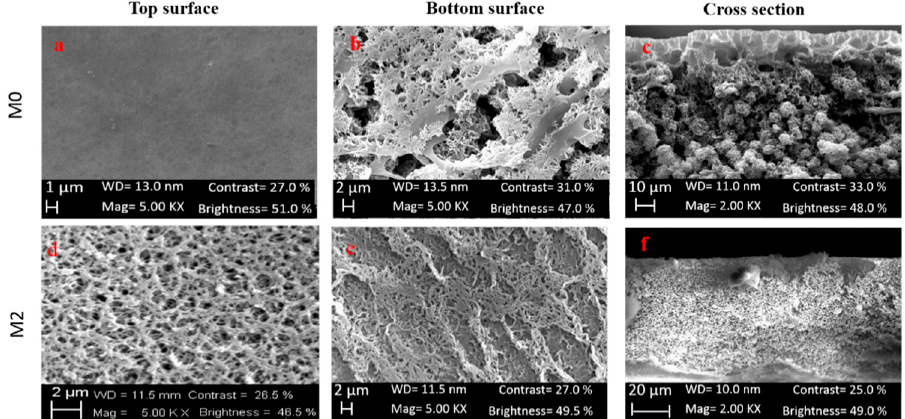
Figure 6. SEM images: top surface, bottom surface and cross-section of membranes M0 and M2.